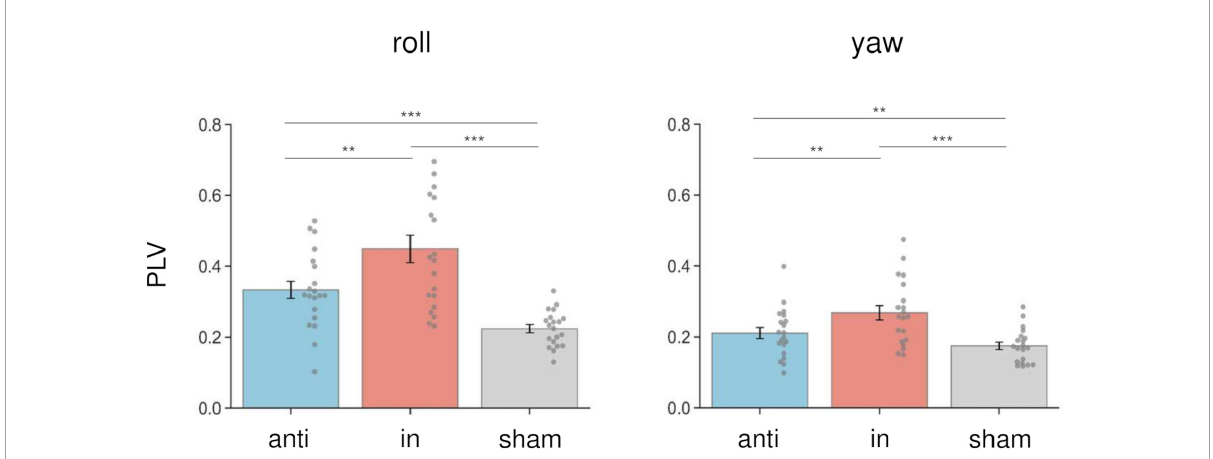
FIGURE7 Effects of combined stimulation on PLV in the roll (left) and yaw (right) directions in Experiment 2. The PLV data were collapsed across sessions in each stimulation condition. In-phase stimulation increased the PLV in the roll and yaw directions compared with the sham and anti-phase conditions. Error bars indicate SEM. ** p < 0.01, *** p <